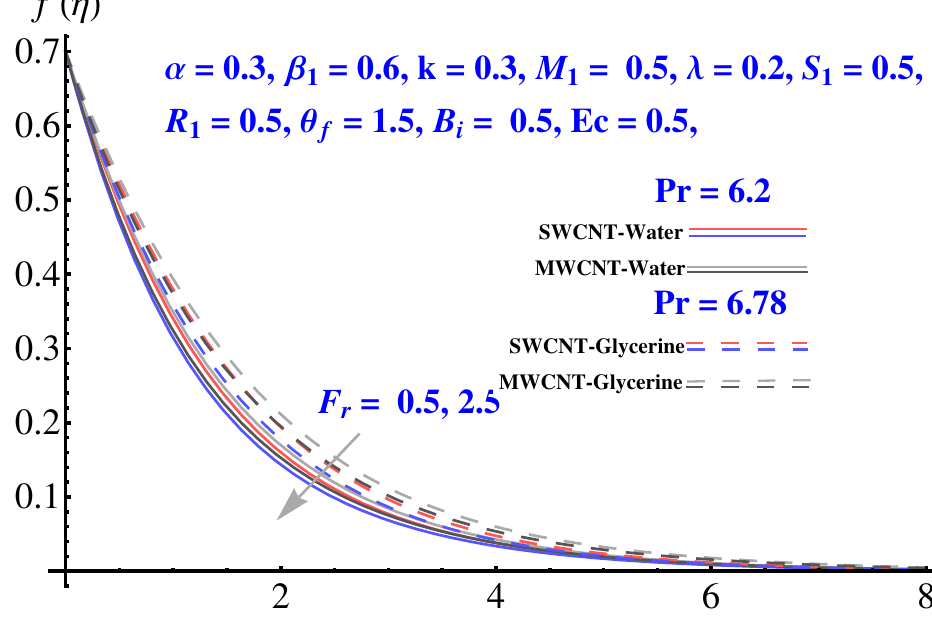
Figure 2. Impact of Fr on radial velocity.